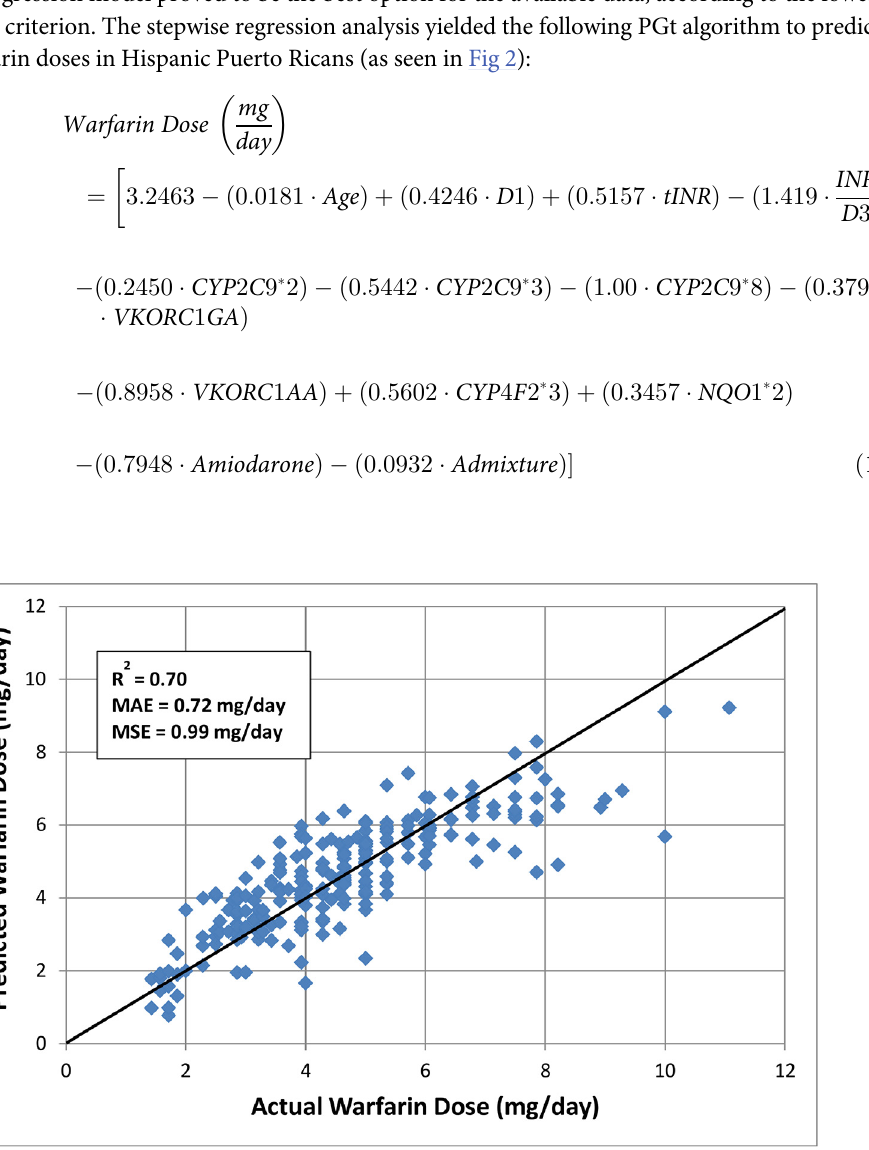
Fig 2. Admixture-adjusted pharmacogenetic warfarin dose refinement algorithm in Caribbean Hispanic patients, developed by using a multiple regression analysis in a derivation cohort of 255 individuals. The solid “ identity ” line illustrates perfect prediction. MAE and MSE stand for the mean absolute error and the mean standard error of estimate,